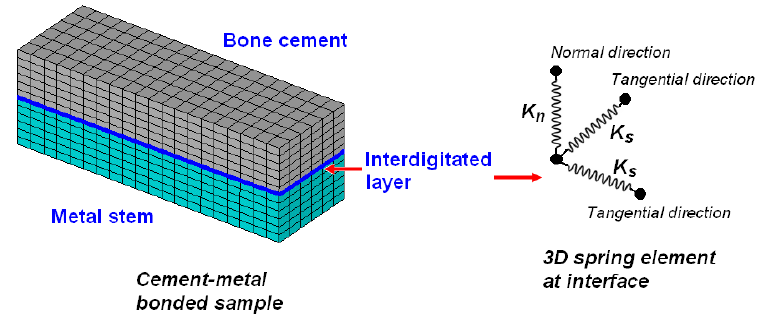
Figure 4. Schematic of the spring layer used to model the bonding between the bone cement and metal stem. metal stem.